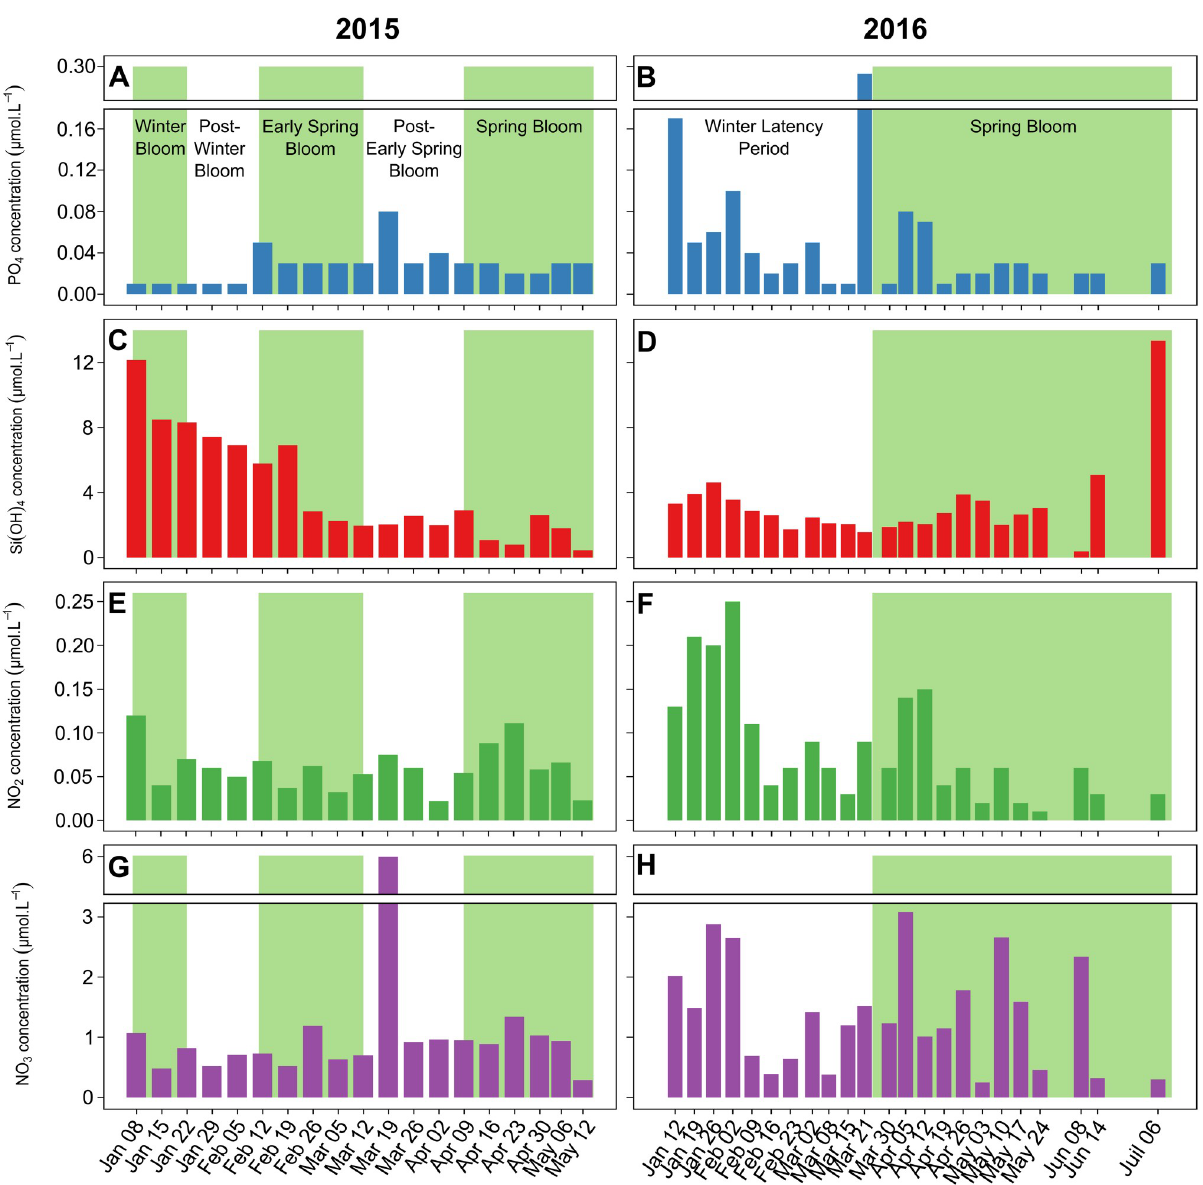
Fig 5. Nutrient concentrations. Nutrient concentrations in 2015 (left) and 2016 (right) for PO 4 (A and B), Si(OH) 4 (C and D), NO 2 (E and F), and NO 3 (G and H). The background colors for the various periods are the same as in Fig